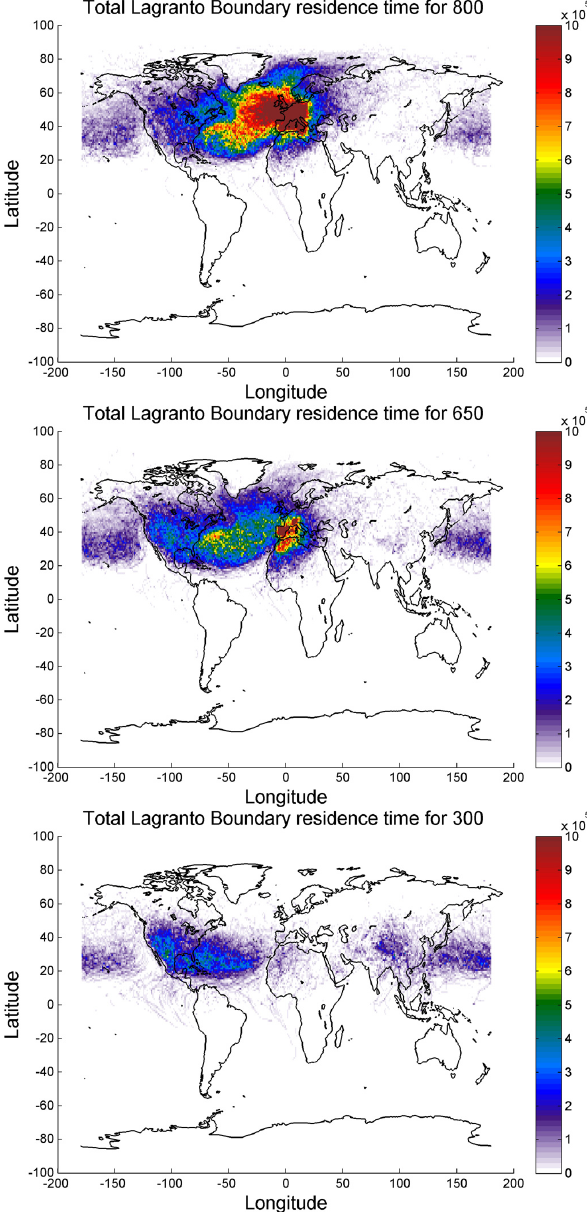
Fig. 8. Total boundary residence time (in seconds) for air masses arriving at Jungfraujoch at 800 (top), 650 (middle) and 300hPa (bottom) averaged over the 1997–2007 period, as simulated by La- granto. Scale is from 0 to 10 × 10 5 s ( ∼ 12